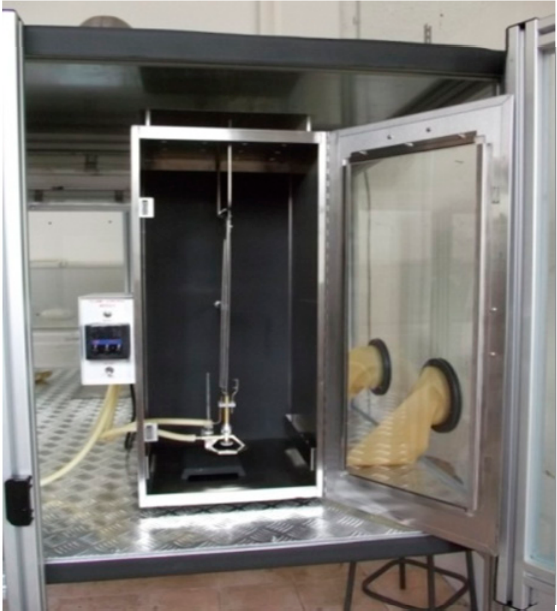
Figure 1. Picture of the flammability test